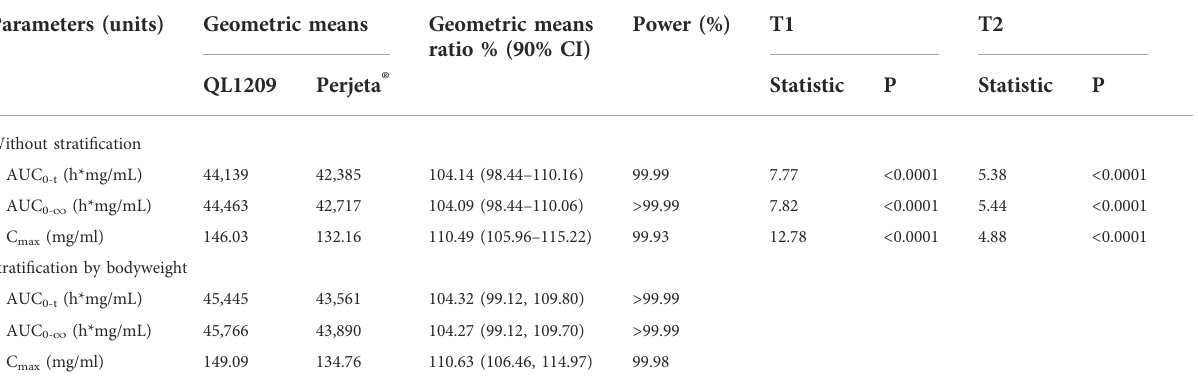
TABLE 3 Statistical comparison of pharmacokinetic